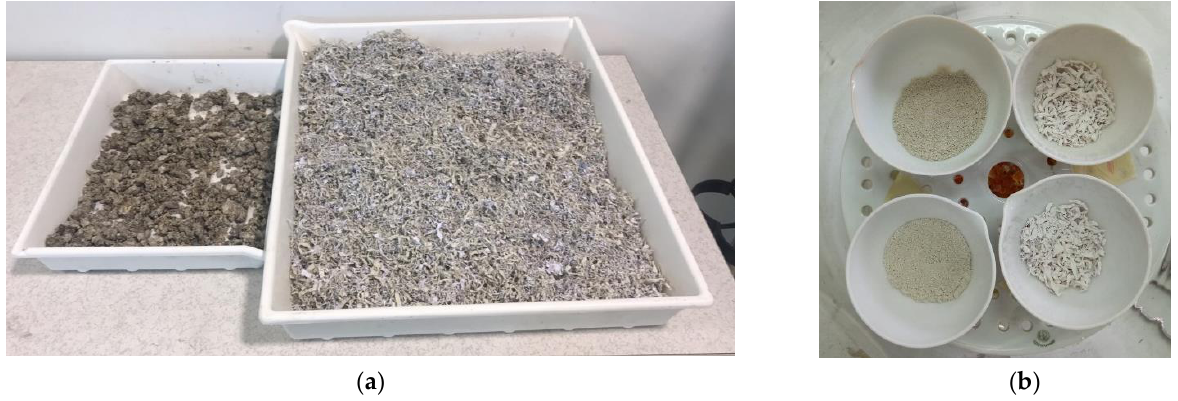
Figure 1. ( a ) Pulp and waste paper utilized. ( b ) Pulp after grinding and waste paper after drying.